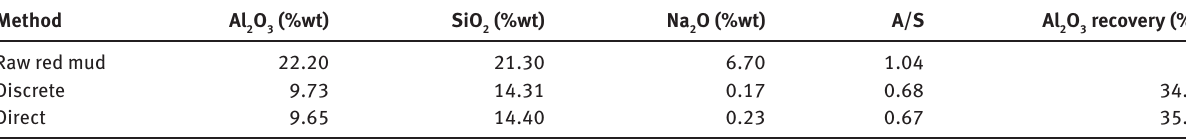
Table 2: Comparison of the discrete and direct processes with respect to alumina recovery and Na